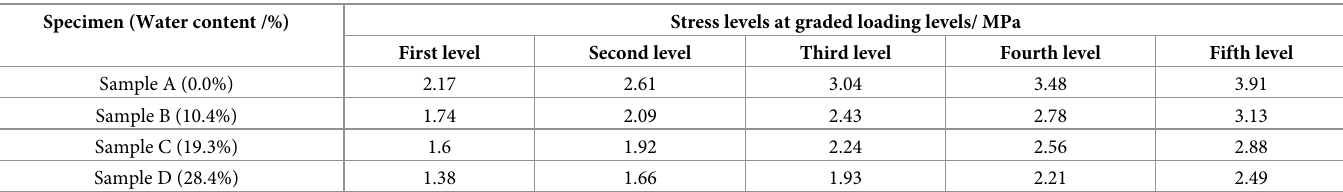
Table 1. Loading parameters for graded load application.